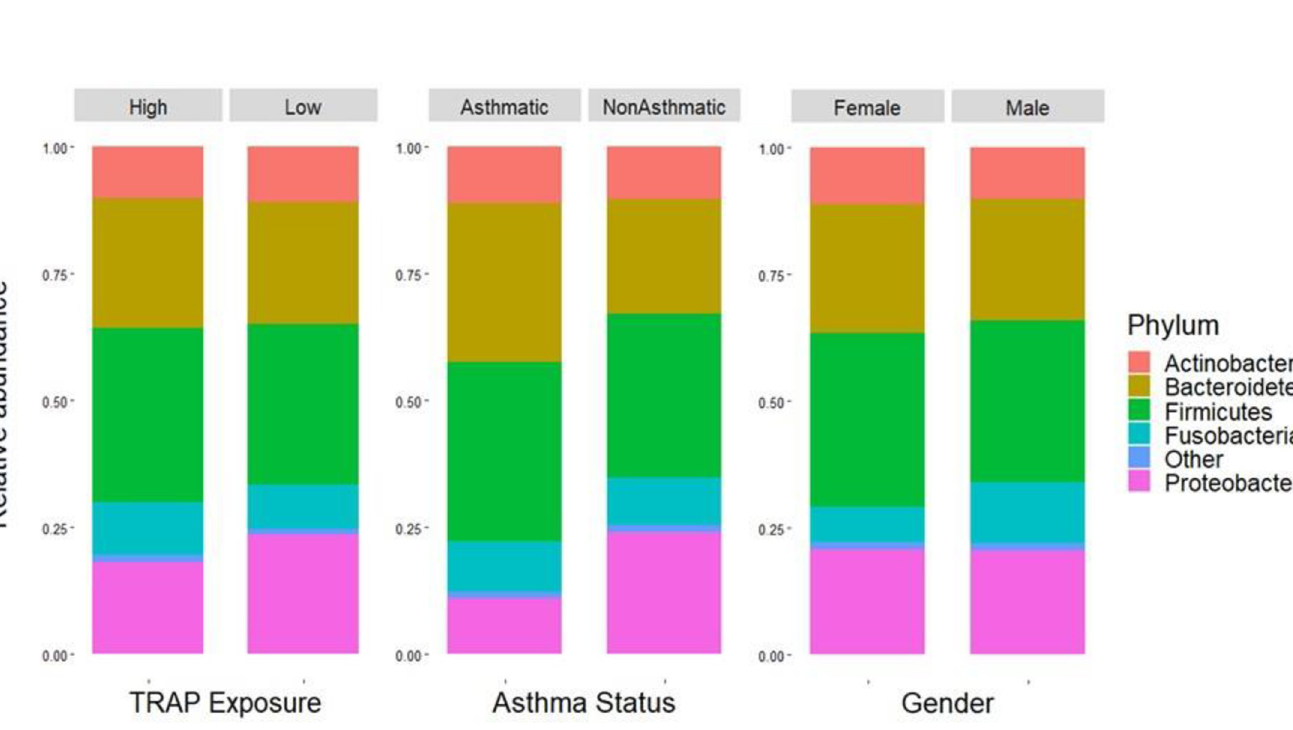
PLOS ONE | https://doi.org/10.1371/journal.pone.0244341 June 24, 2021 11 /